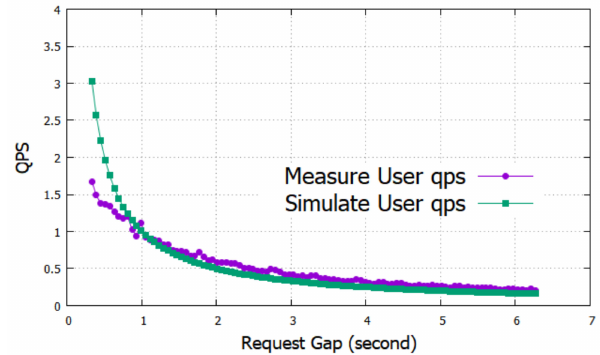
Figure 6. Comparison of measurement results with simulated data.